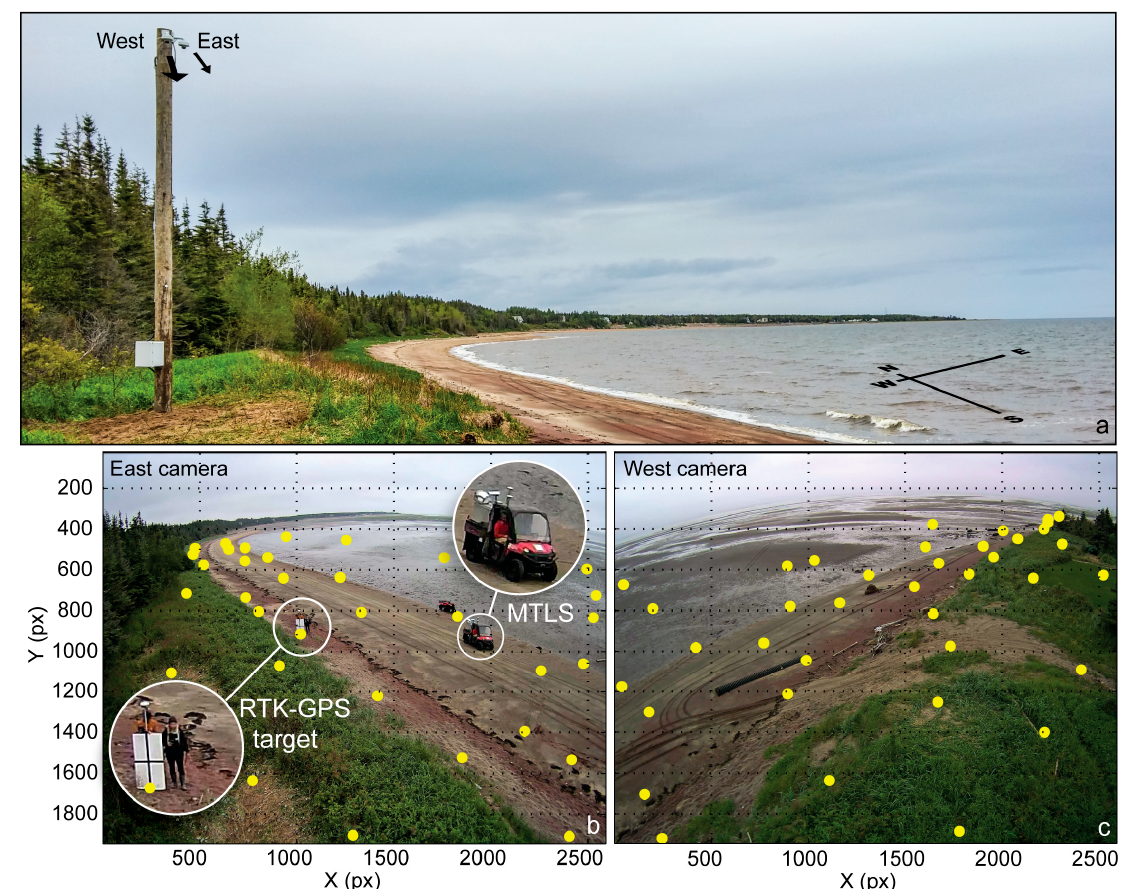
Figure 5. The video camera system of Pointe-Lebel is located at 5 m from the beachface ( a ). Ground Control Points (GCPs showed as yellow dots) for image to ground coordinate conversions were acquired with RTK–GPS on the beachface and the tidal flat during the LiDAR survey on the east ( b ) and west side of the beach ( c ) on 3 August 2016. The GCPs and LiDAR acquisitions are shown in ( b ).